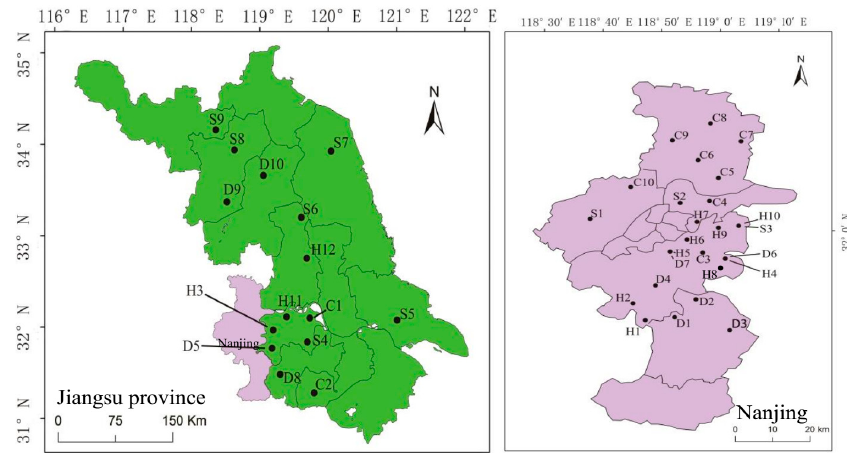
Figure 2. Sampling sites for livestock waste in Jiangsu Province, China. H1–H12 represents 1–12 sampling sites for henneries; D1–D10 represents 1–10 sampling sites for duck farms; C1–C10 represents 1–10 sampling sites for cow farms; and S1–S9 represents 1–9 sampling sites for swine farms.